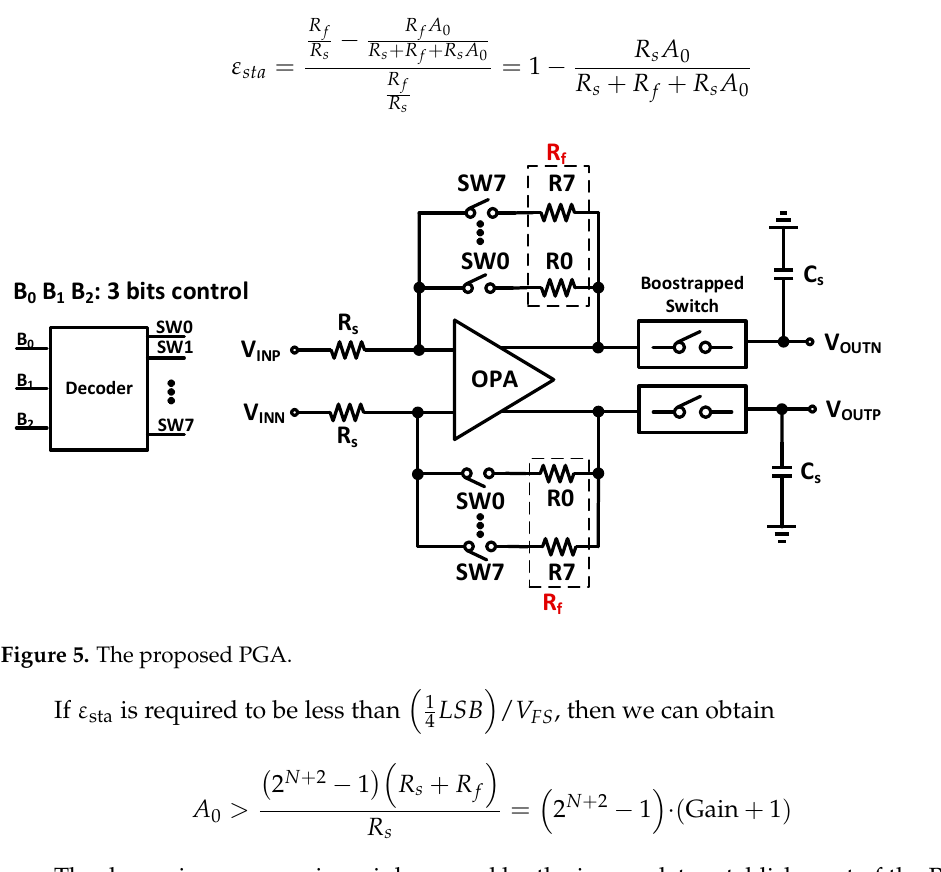
Figure 5. The proposed PGA.